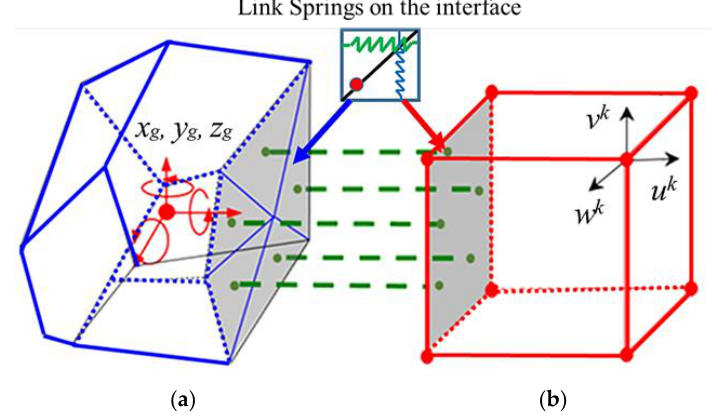
Figure 5. The boundary interface of a coupled RBSM and solid FEM model: ( a ) Representation of RBSM element; ( b ) Representation of eight-noded solid FEM element [39,40].